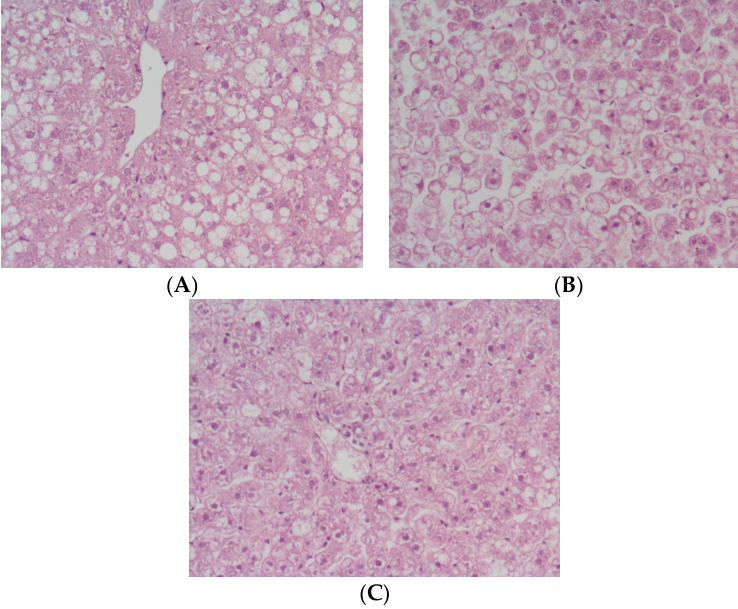
Figure 2. Histology hematoxylin–eosin staining. Photomicrographs of livers at 20× magnification: ( A ) Control group showing normal hepatic architecture with macro- and micro-vesicular fatty infiltration; ( B ) HTK group. Extensive areas of cell dissociation, cell swelling and disintegration of hepatic architecture are seen ( C ) IGL group. Well-preserved lobular architecture with minimal sinusoidal dilatation and cell swelling are observed .